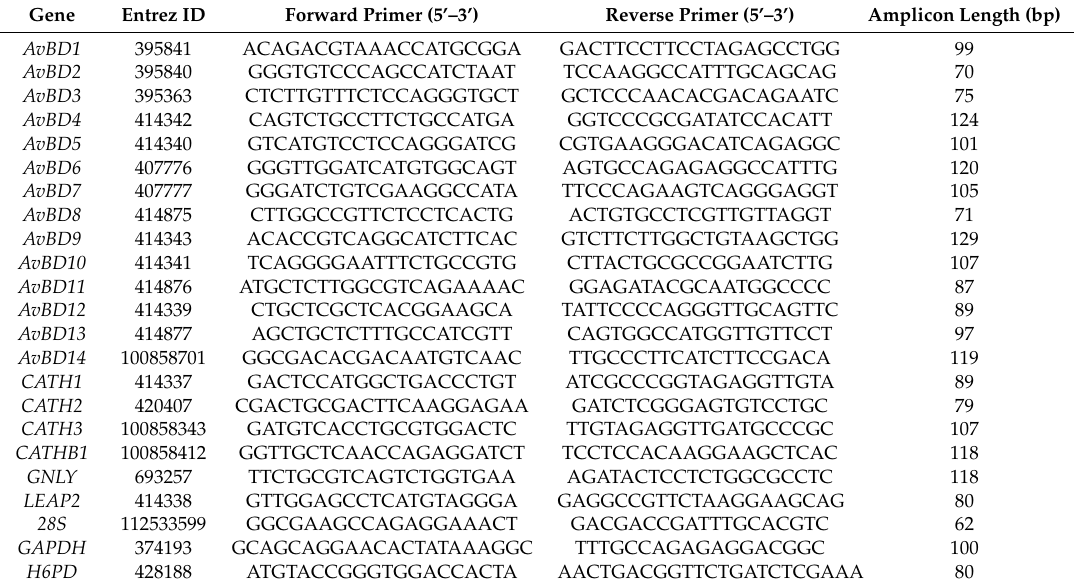
Table 1. Primer information for host defense peptide genes and reference